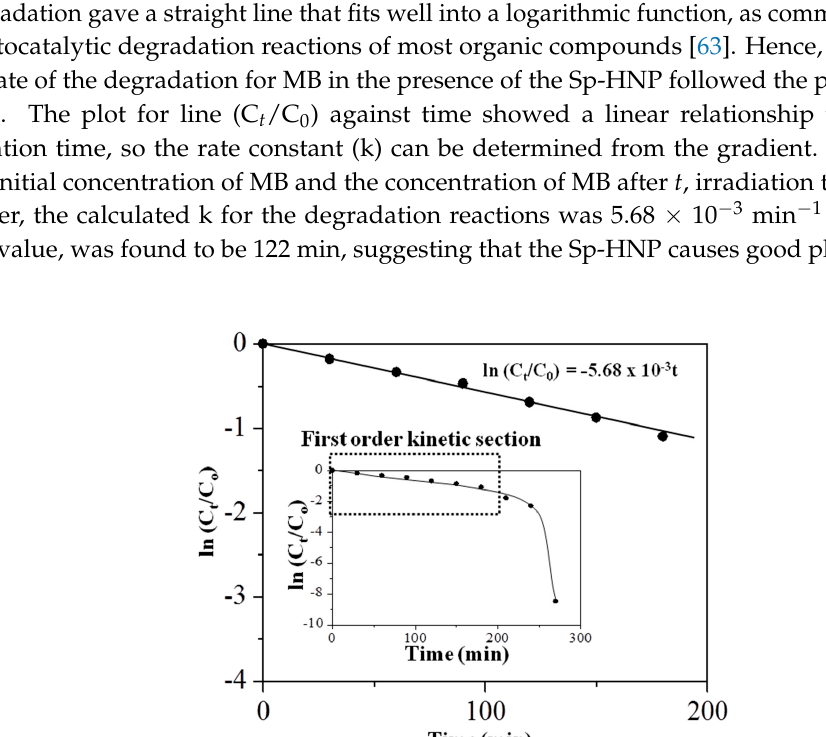
Figure 10. Concentration of MB as a function of the irradiation time for 180 min. The inset shows the concentration of MB for the full irradiation time from 0 to 270 min with the first-order kinetic section defined in the dotted box.